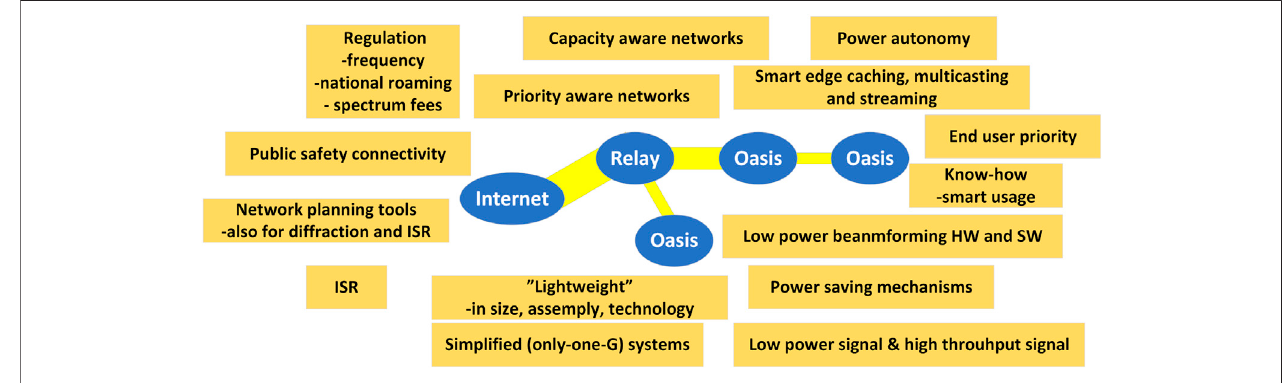
FIGURE 7 | Terrestrial wireless backhaul requirements and some solution pathways.